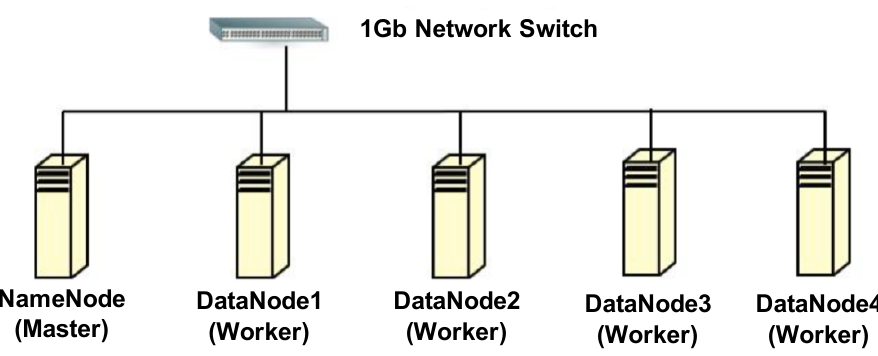
Figure 1. The testbed cluster for